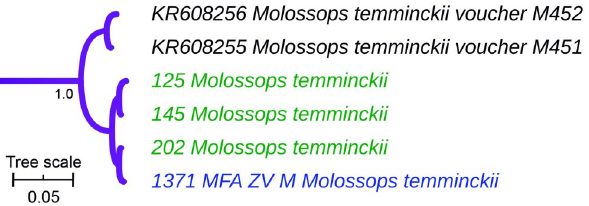
Fig 5. Cytochrome b -based Bayesian phylogeny of Molossops . Branch width represents internal node support. Terminal font color indicates sequence source: black indicates sequences retrieved from Genbank, green indicates museum voucher sequences obtained in this study, while blue color indicates samples captured at the field and sequenced in this study. The scale units are substitutions per site. Main clades posterior probability values are annotated.